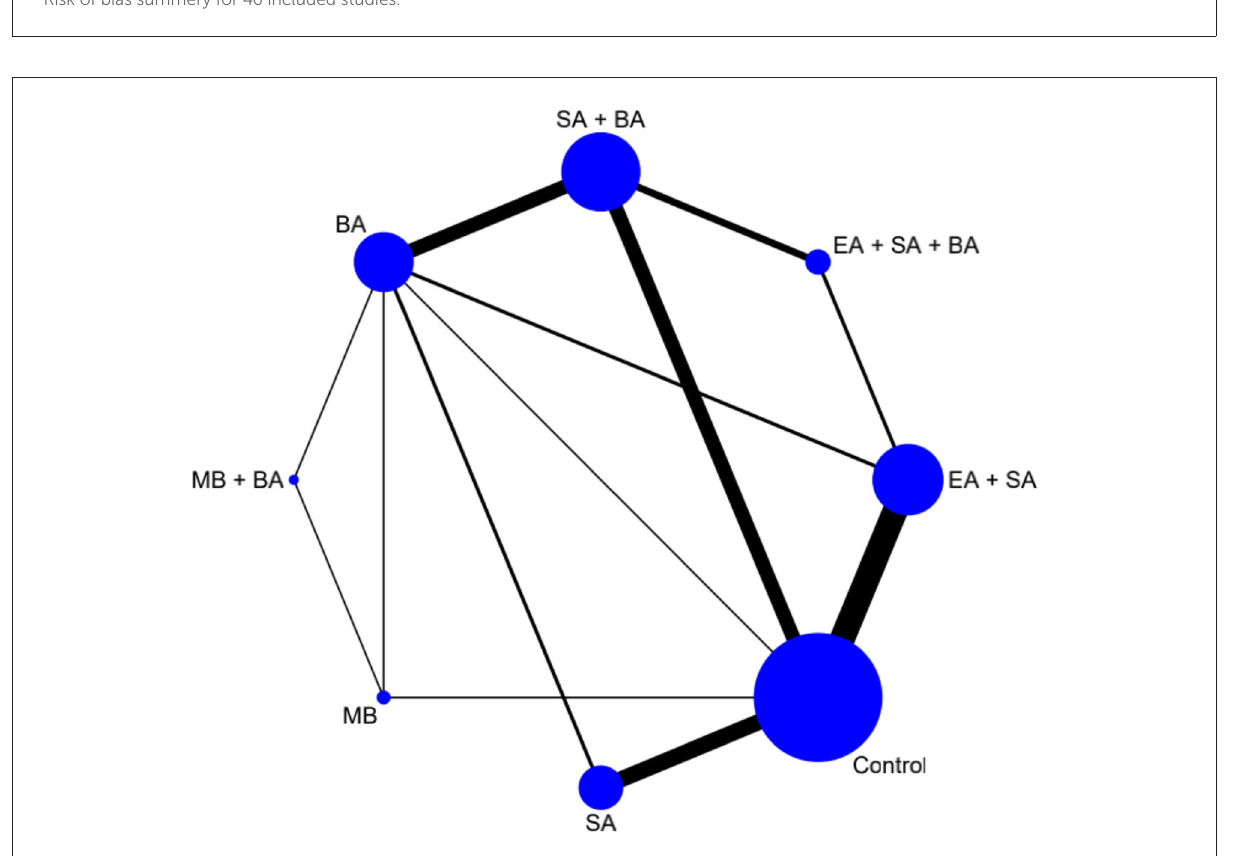
may be more effective in relieving dementia symptoms than BA (0.35, 95% CI: − 0.22–0.92). However, there were no appreciable differences between these acupuncture therapies in terms of improving cognitive function. However, acupuncture combined